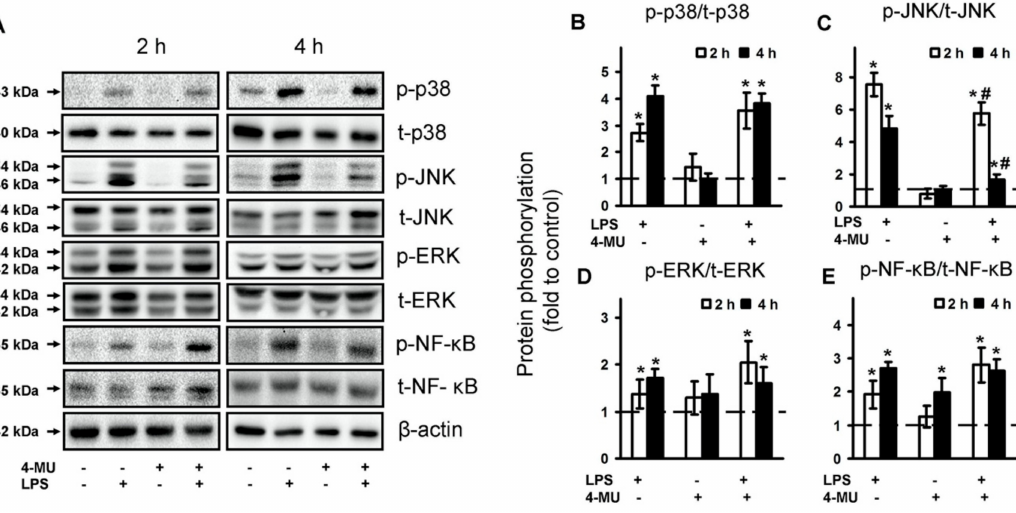
Figure 4. Comparison of NF-kB, p38, JNK and ERK1 / 2 MAPK activity in the LPS-stimulated astrocytes, treated with 4-MU. Astrocytes were pretreated for 30 min with 4-methylumbelliferone (4-MU, 400 µ M) and subsequently kept for 4 h without any additional stimulation or with lipopolysaccharide (LPS, 100 ng / mL). p38, p-p38, pJNK, JNK, pERK1 / 2, ERK1 / 2 mitogen-activated protein kinases (MAPKs), nuclear factor kappa-light-chain-enhancer of activated B cells (p-NF-KB and NF-kB) protein levels were evaluated by western blotting at indicated time (given in h) and normalized to the loading control β -actin. ( A ) Representative Western blots demonstrating phospho-p38 (p-p38), phospho-JNK (p-JNK), phospho-ERK1 / 2, phospho-NF-kB and total p38 (p38), total JNK (JNK), total ERK1 / 2 and total NF-kB protein levels. The example is representative for three independent experiments. ( B – E ) Results are expressed as fold-changes, relative to untreated control astrocytes. Values represent mean ± SEM from three independent experiments. * p < 0.05, compared with the unstimulated cells, # p < 0.05 compared with the LPS-stimulated